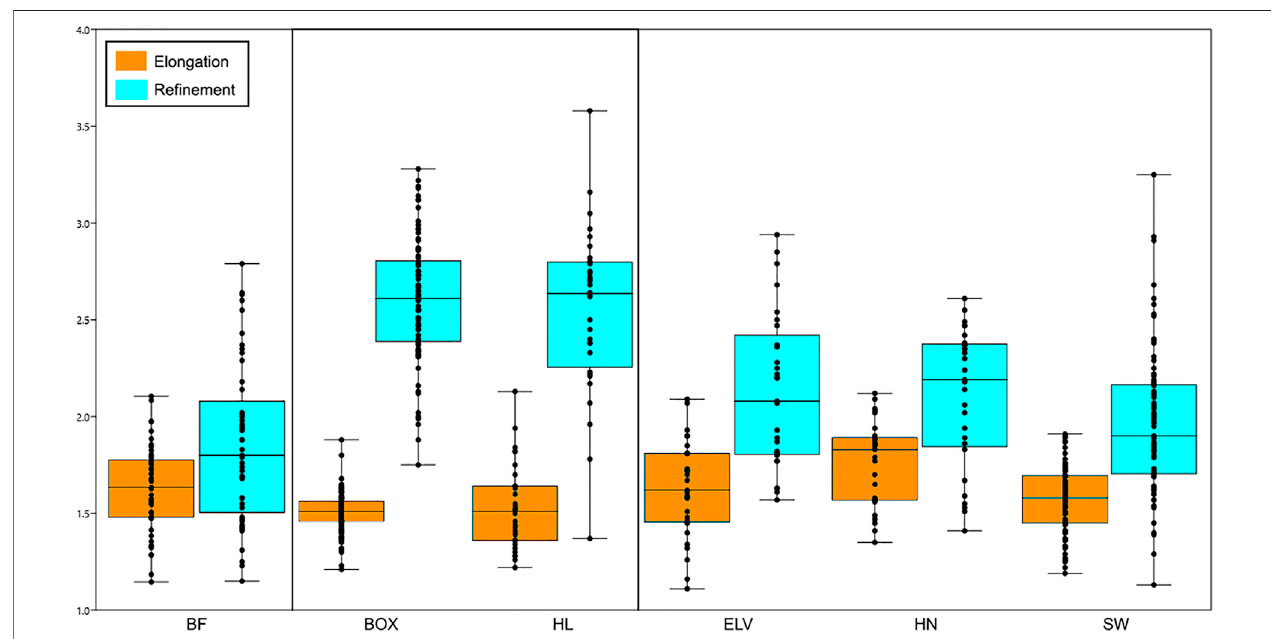
FIGURE 1 | Boxplot with jitter of elongation and re fi nement values per sites. Abbreviations: BF, Brandon Fields; BOX, Boxgrove; HL, High Lodge; ELV, Elveden; HN; Hitchin, SW, Swanscombe.